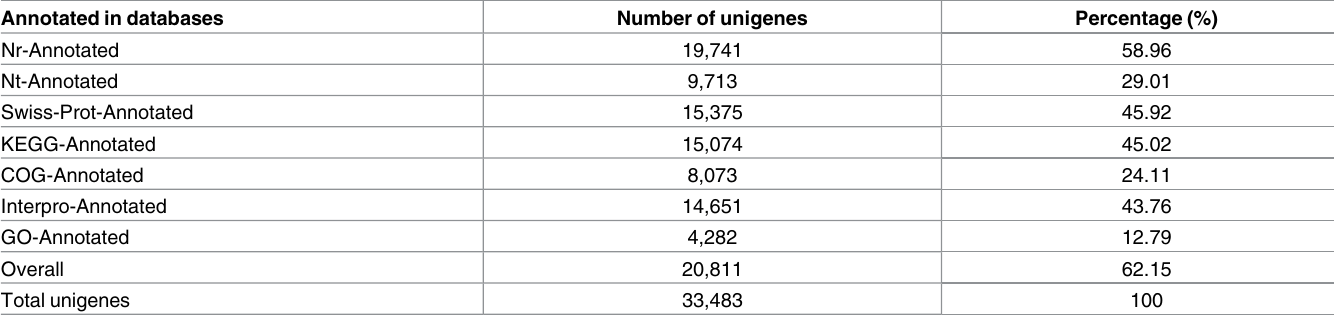
Table 4. Distribution of unigenes in different public